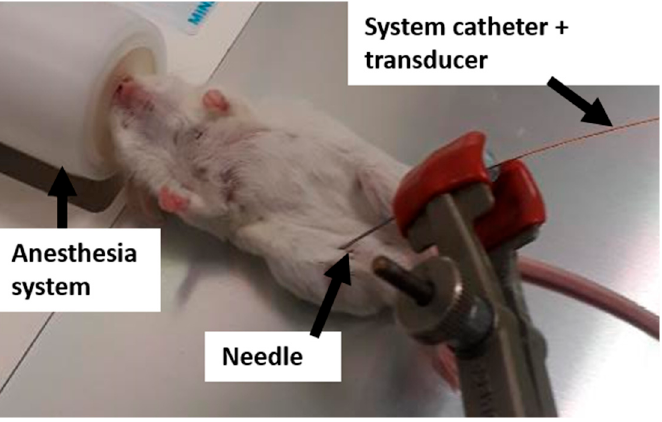
Figure 4. Experimental setup to measure tumor pressure with a catheter-mounted piezoelectric transducer.